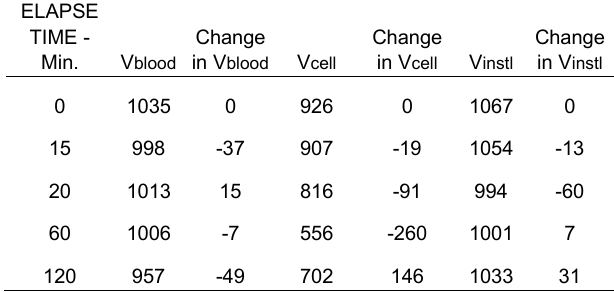
Table 1. Vblood, Vcell, Vinstl Volumes and Changes in Volume (all mL) at Elapsed Times (min.) of changes in the DTM